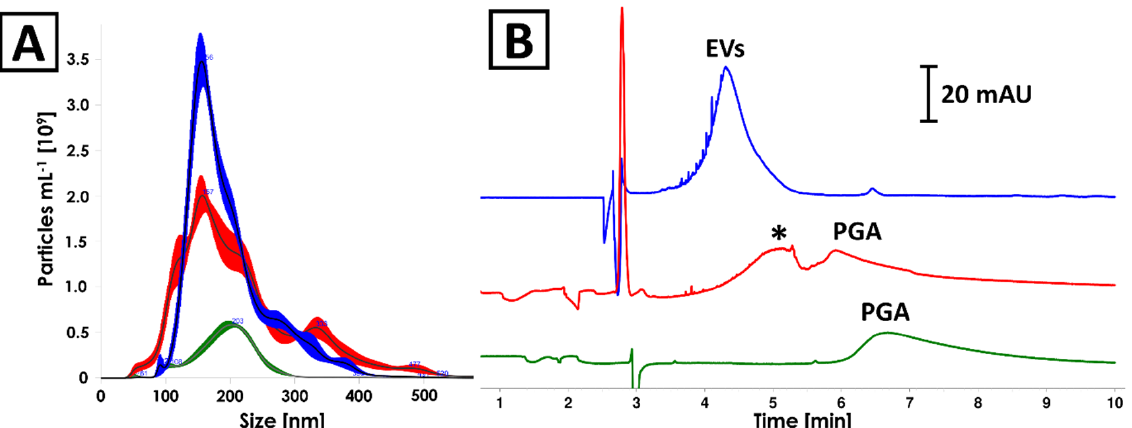
Figure 3. Comparison of ( A ) NTA and ( B ) CE analyses results of isolates obtained from (blue) Pectobacterium zantedeschiae culture, (red) culturing medium composed of M63 medium, 0.2% glycerol and 0.4% PGA, and (green) 0.4% PGA solution. The isolation process was described in Section 4.6. Asterisk (*) indicates unidentified component of the culturing medium